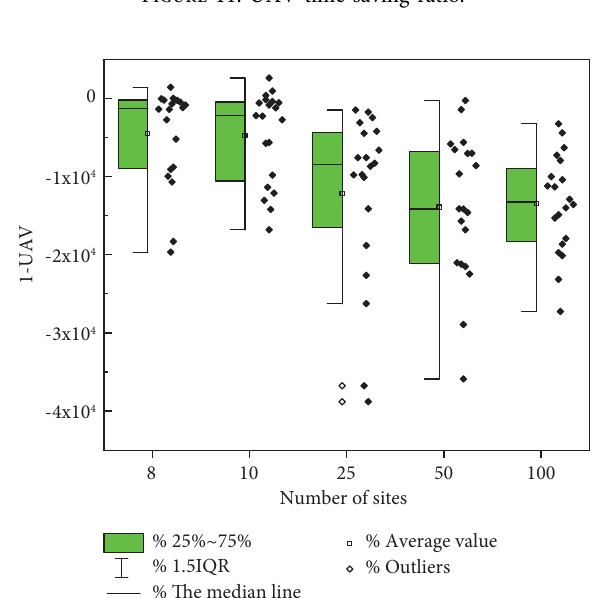
Figure 11: UAV time saving ratio.